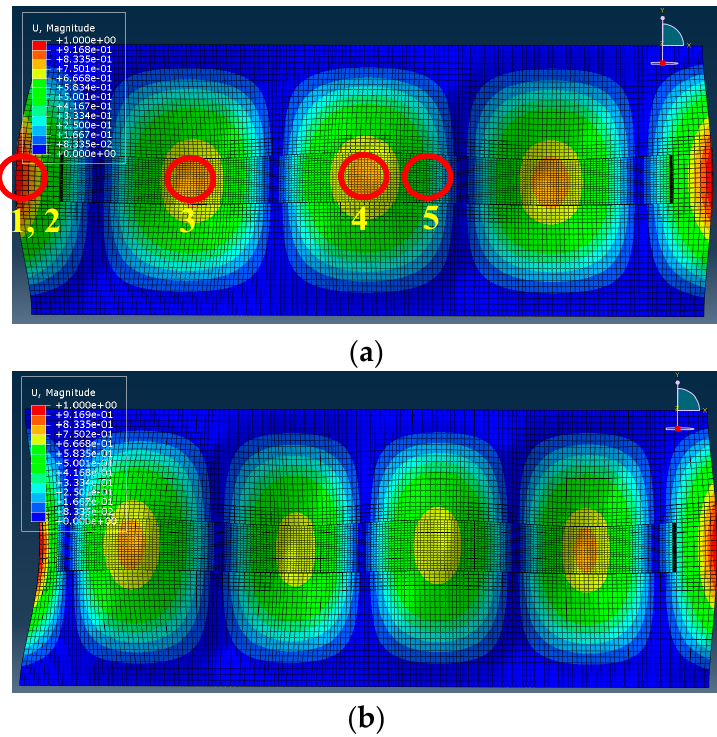
Figure 5. Modes 5 ( a ) and 6 ( b ) predicted by the frequency analysis of the numerical model.